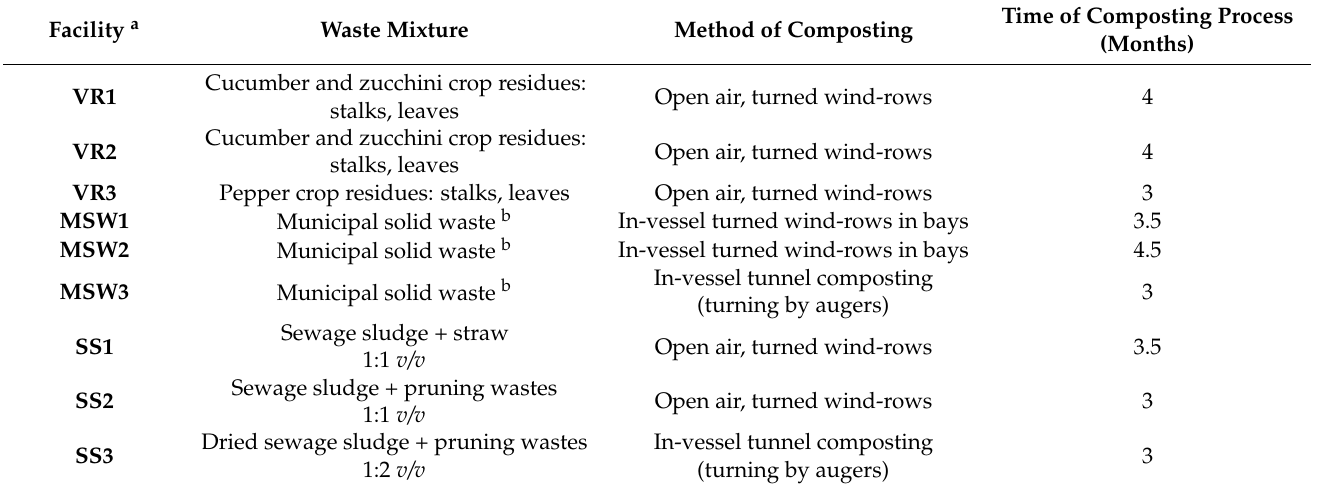
Table 1. Characteristics of the industrial composting